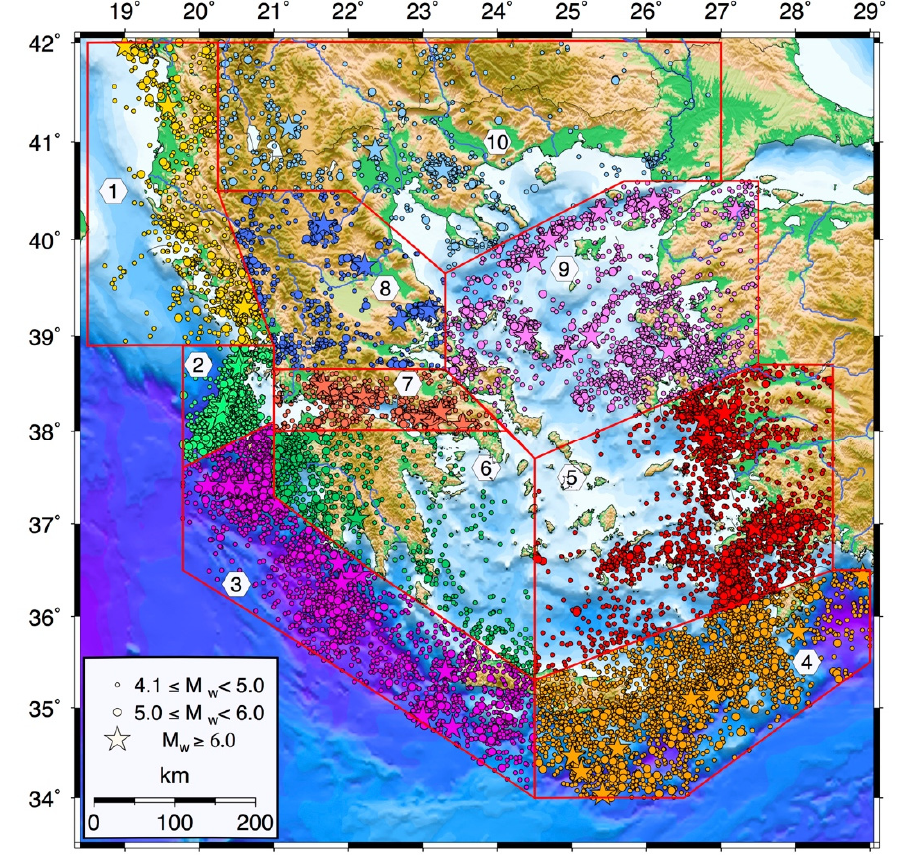
Figure 2. Epicentral distribution of Greek seismicity with M w ≥ 4.1 since 1975. Each different color illustrates the earthquakes of the 10 distinctive sub-areas that the broader Aegean region is divided (the borders of each sub-area are denoted with red polygons).